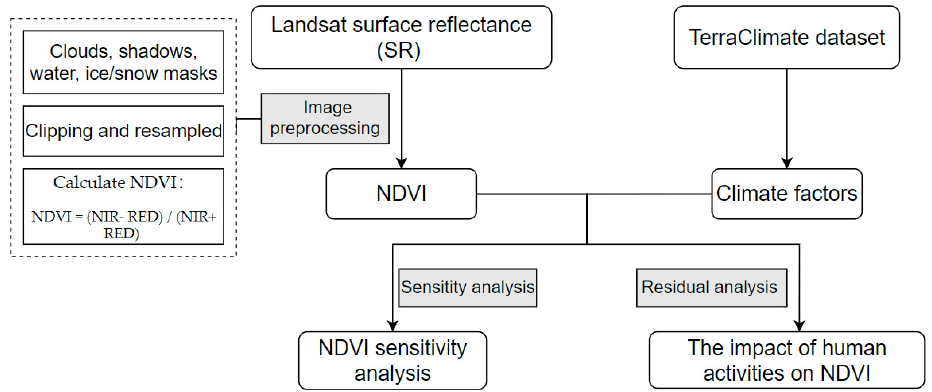
Figure 2. A flow chart of NDVI calculation, and the correlation analysis of human activities and climate change on NDVI.